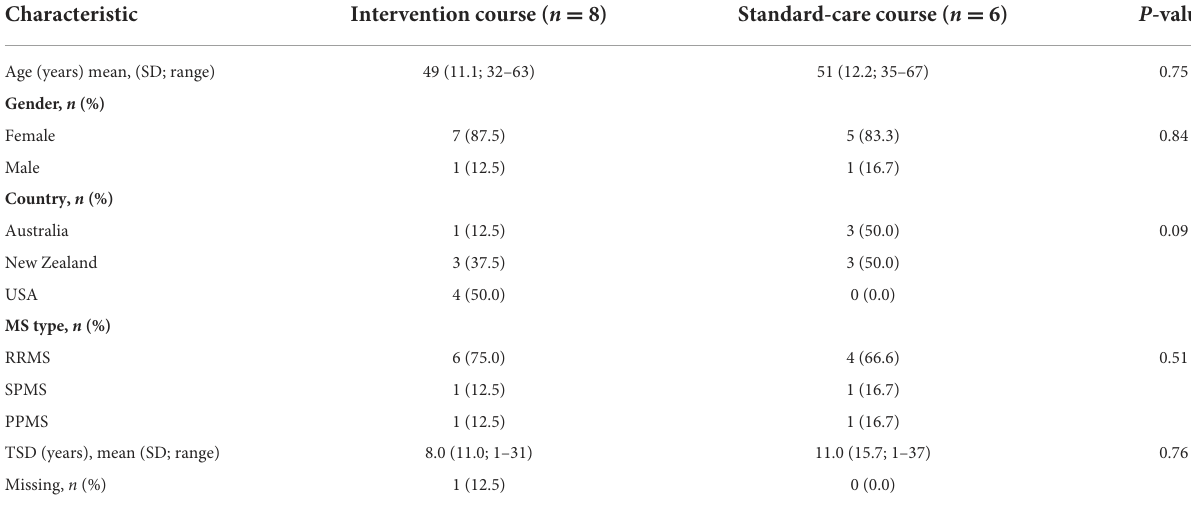
TABLE 1 Characteristics of participants in the MSOC qualitative study.